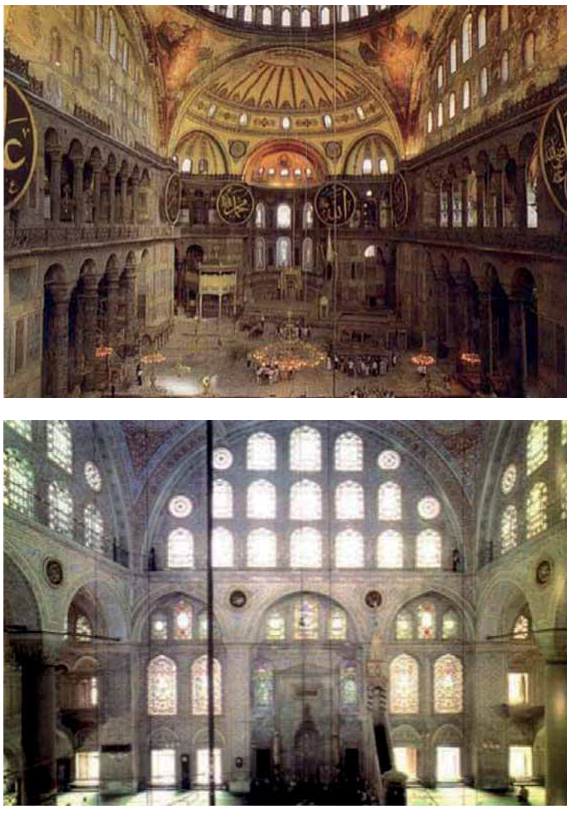
fig. 2. Hagia Sophia and Mihrimah Sultan